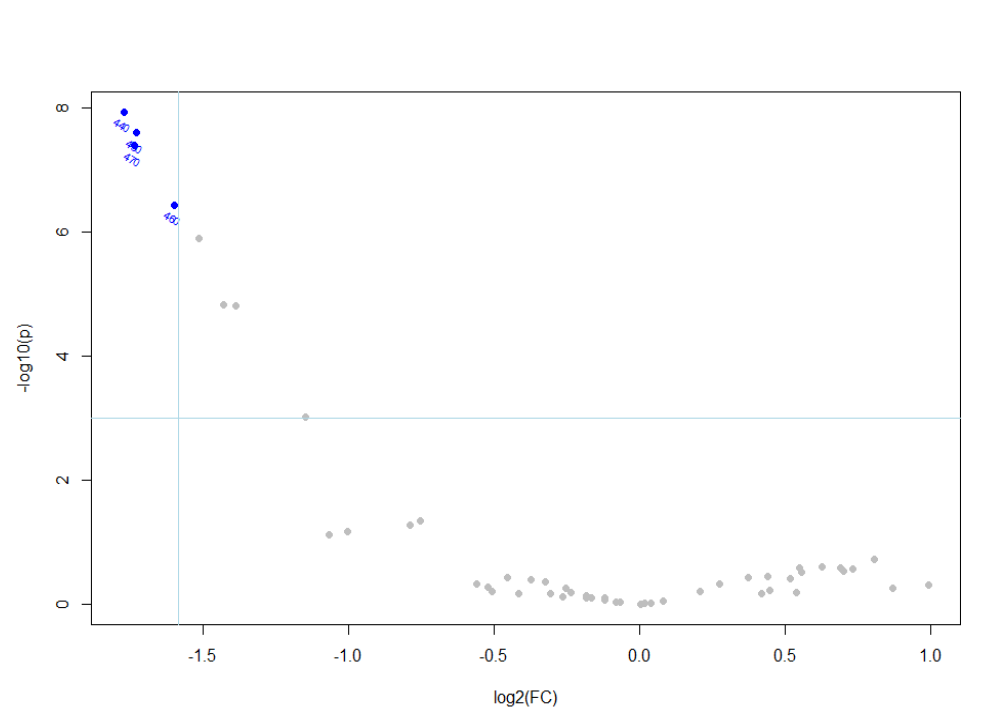
Figure 3: Volcano plot analysis (Fold change threshold = 2 and p ≤ 0.001). The larger magnitude fold changes and the higher statistical significance refer to wavelengths between 440-470 nm. (blue